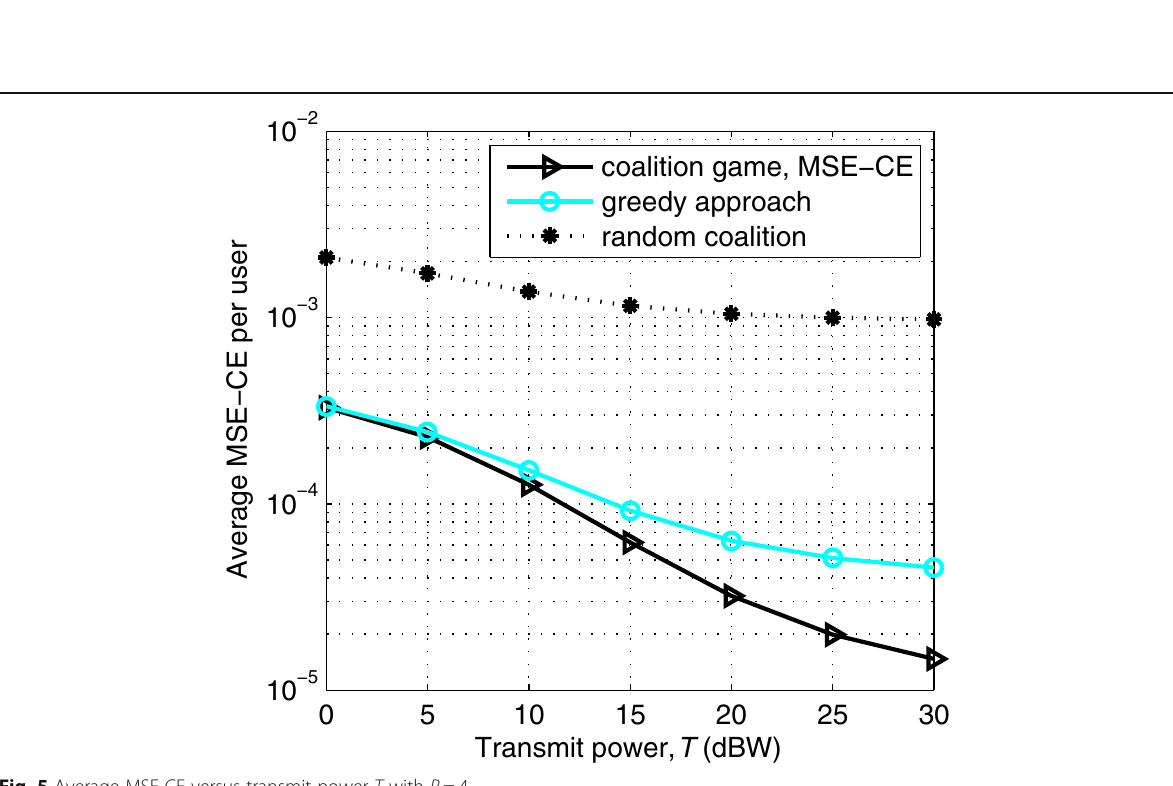
Fig. 5 Average MSE-CE versus transmit power T with P =